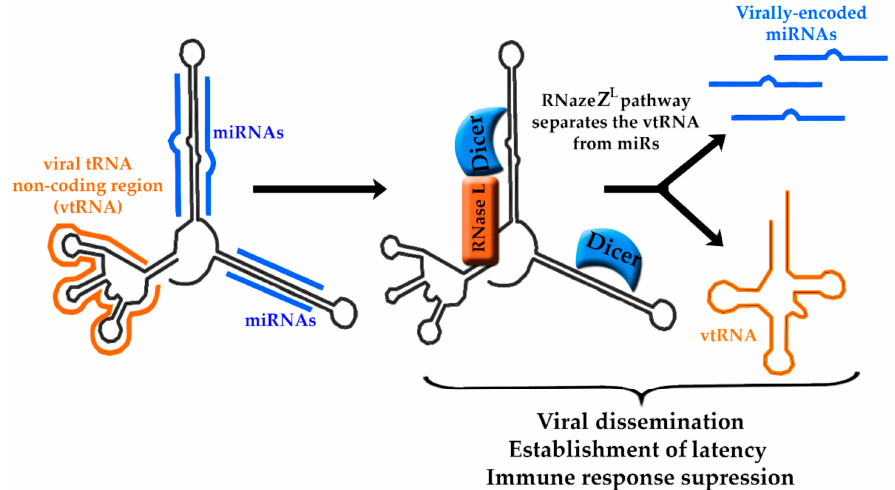
Figure 3. Maturation pathway of TMERs. Each TMER transcript contains a viral tRNA non-coding region (vtRNA, orange) and microRNA (miRNA) hairpins (blue). Through the RNaseZ L pathway, the vtRNA is separated from the hairpins that are then processed by Dicer into miRNAs. TMERs are essential for the establishment of latency and viral dissemination, however, due to their close structural relationship their individual functions are not well